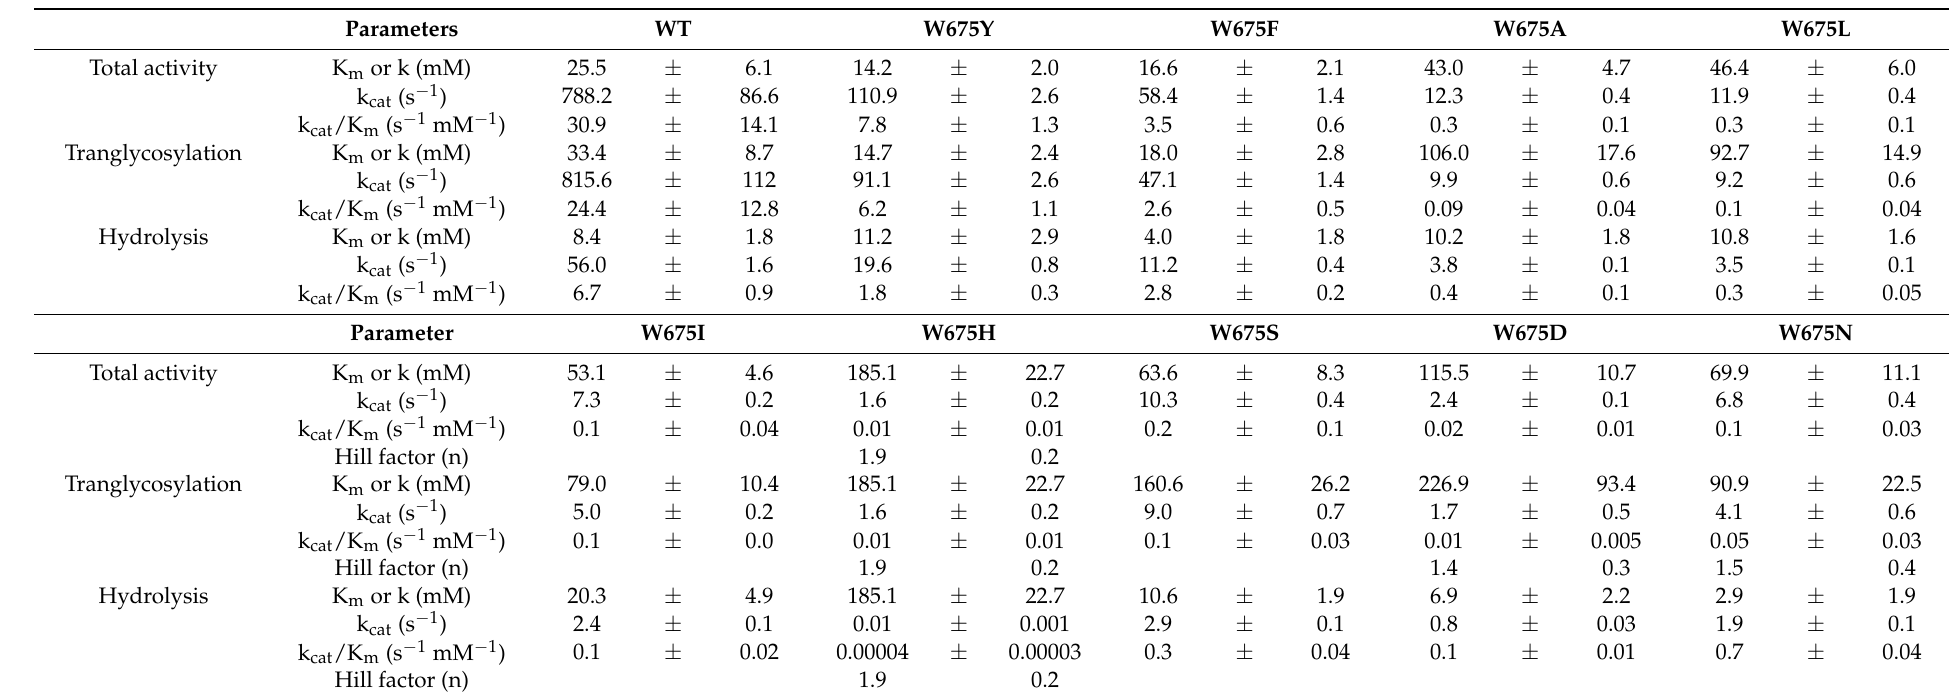
Table 1. Kinetic parameters of WT alternansucrase and its mutants substituted at W675